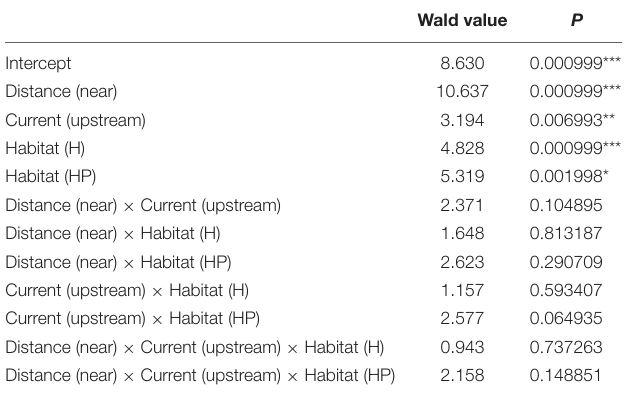
TABLE 2 | Multivariate GLM results for the whole amphipod assemblage showing significant different between factor levels and associated P -values (* P < 0.05, ** P < 0.01, and *** P <